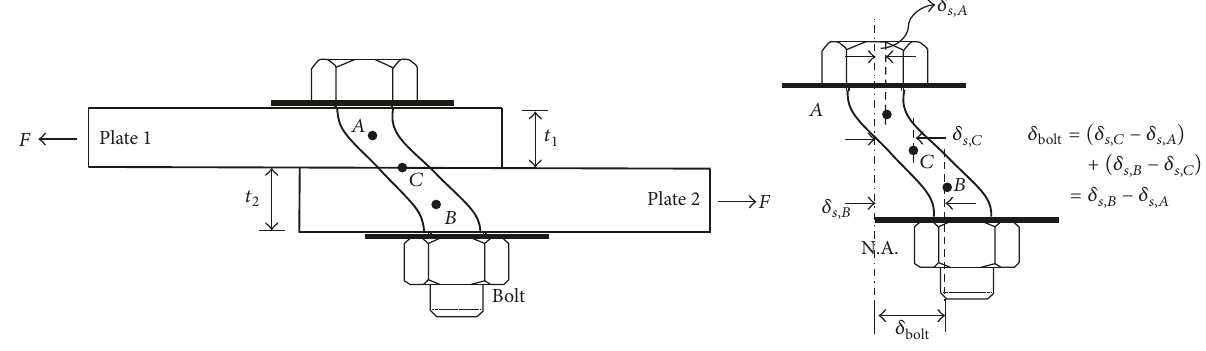
Figure 15: Shear deformation of the